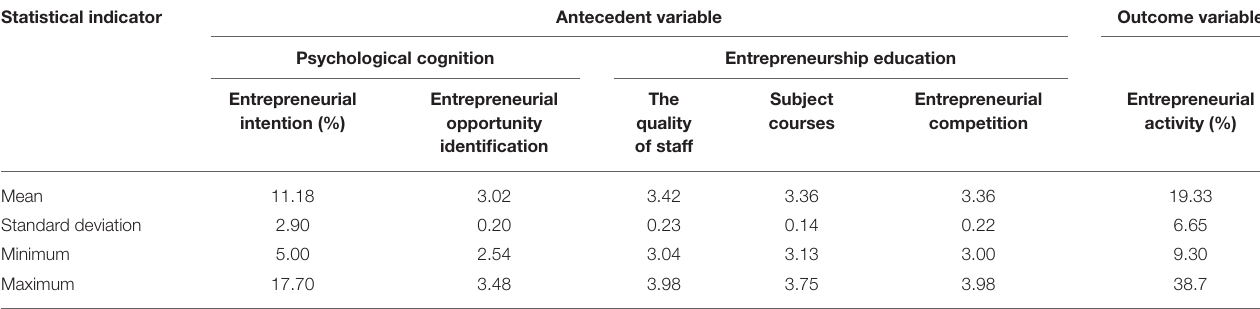
TABLE 2 | Descriptive statistical analysis results of the research variables.